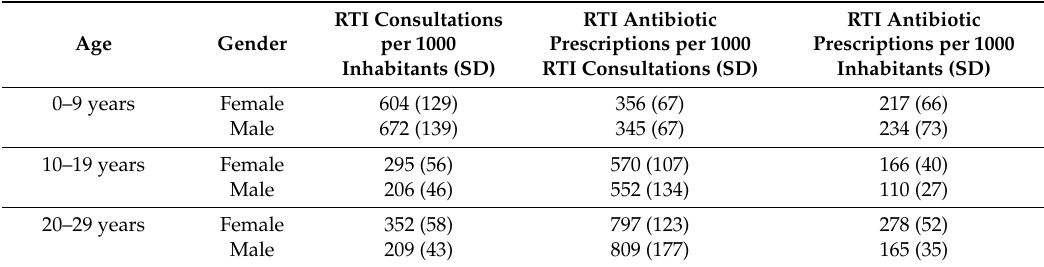
Table 2. Respiratory tract infections (RTI) consultations per 1000 inhabitants, RTI antibiotic prescription per 1000 RTI consultations and RTI antibiotic prescriptions per 1000 inhabitants in 198 Norwegian municipalities in Norway in